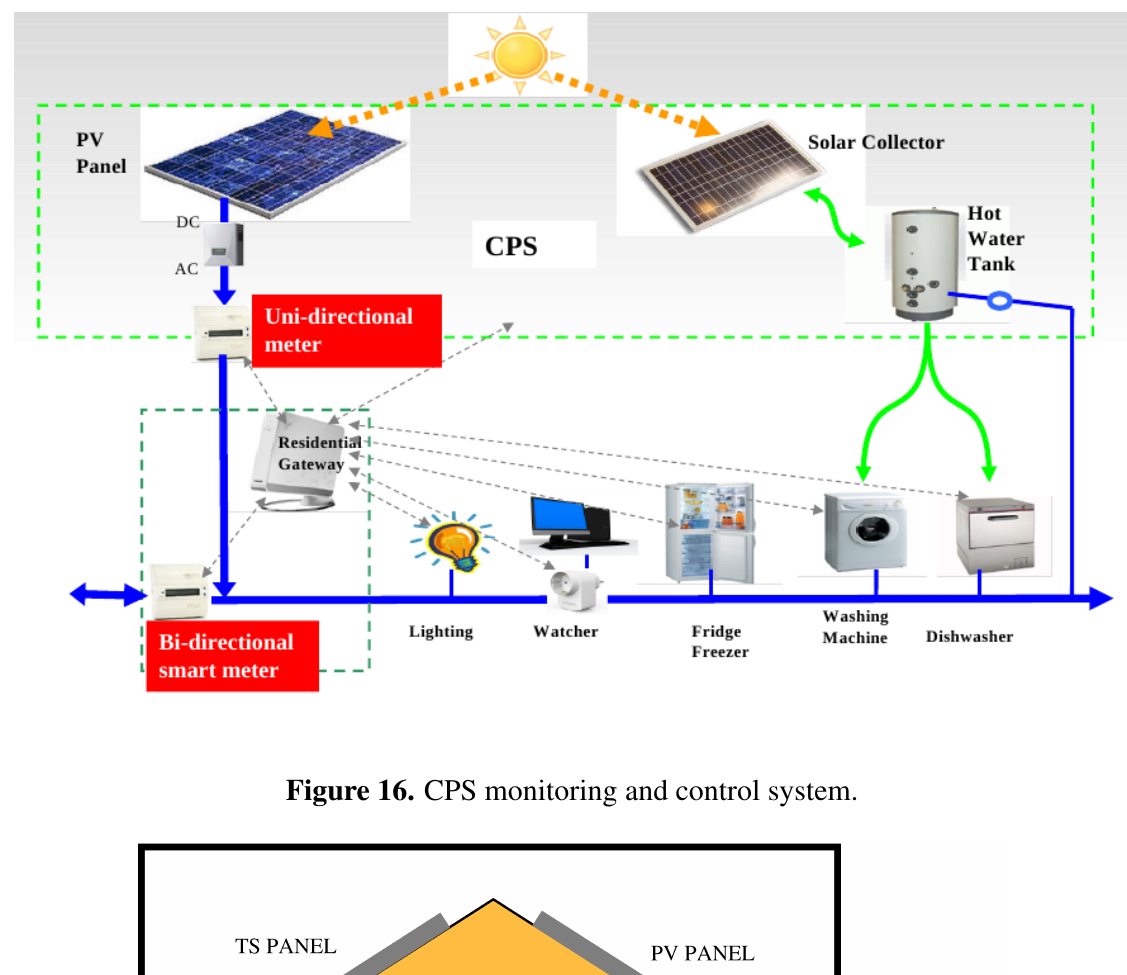
Figure 15. CPS architecture.